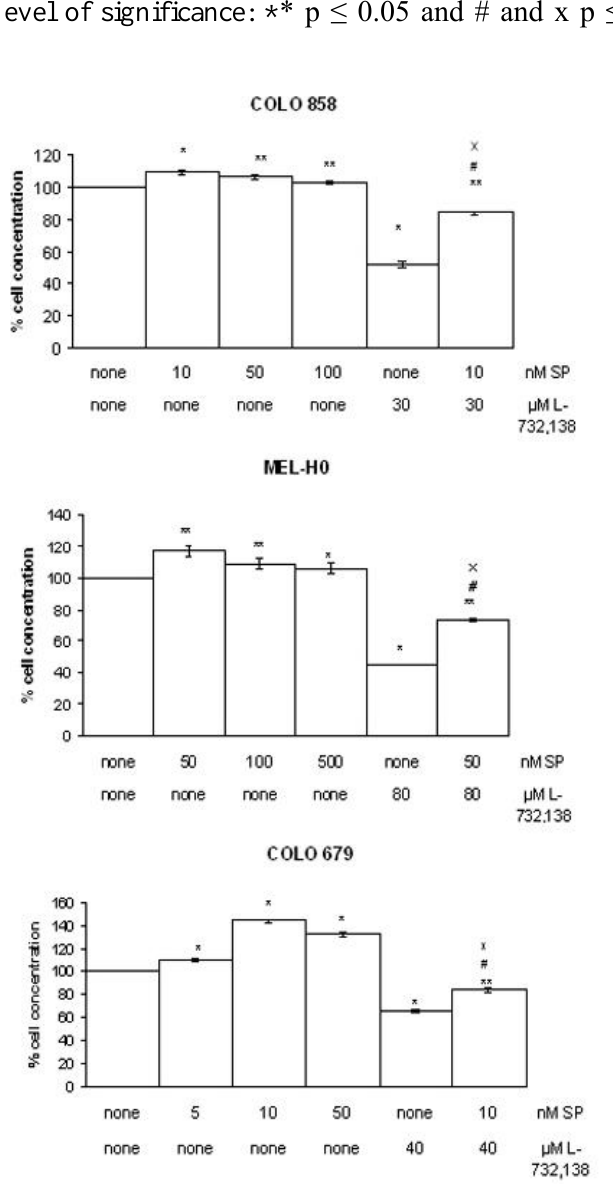
Figure 2. Induction of cell proliferation of COLO 858, MEL HO and COLO 679 human melanoma cells by SP at several nanomolar concentrations (5, 10, 50, 100 and 500